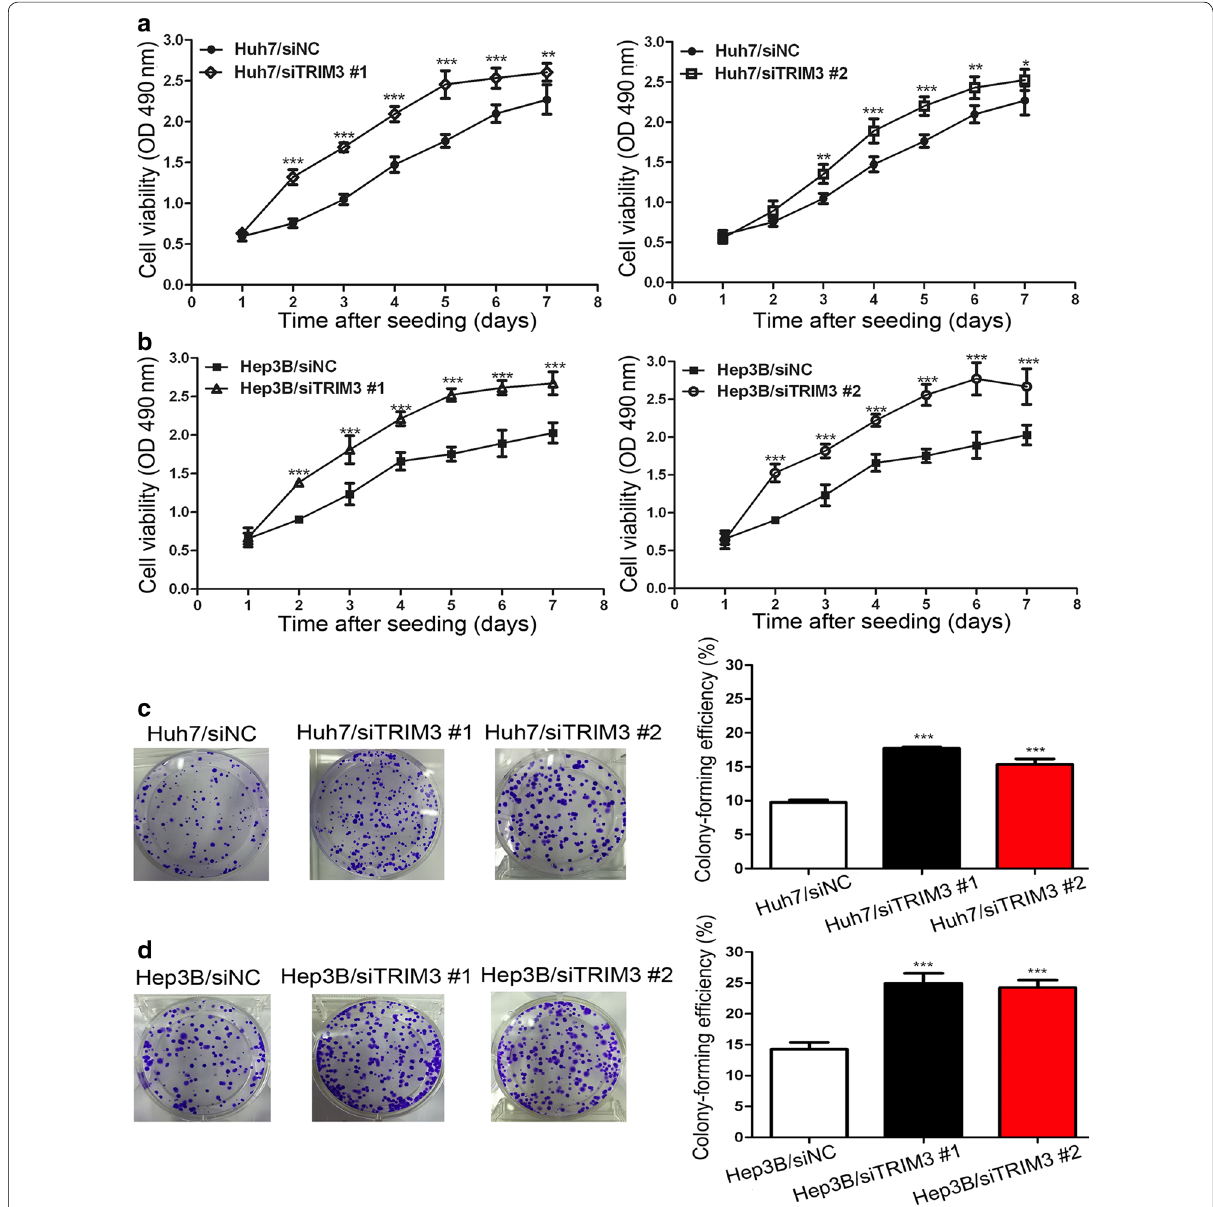
Fig. 3 Promotion of Huh7 and Hep3B cell growth by TRIM3 silencing. a , b Proliferation assay results show that silencing TRIM3 expression pro‑ moted proliferation of Huh7 ( a ) and Hep3B ( b ) cells. c , d Left representative images of increased colony formation in a monolayer culture by silenc‑ ing TRIM3. Right colony‑forming efficiencies were calculated after 12‑day conventional culture. Measurements were carried out in triplicate, and experiments were repeated three times. Data are presented as mean SD. P values were calculated using Student’s t test. * P < 0.05, ** P < 0.01, and ± *** P < 0.001, versus cells transfected with